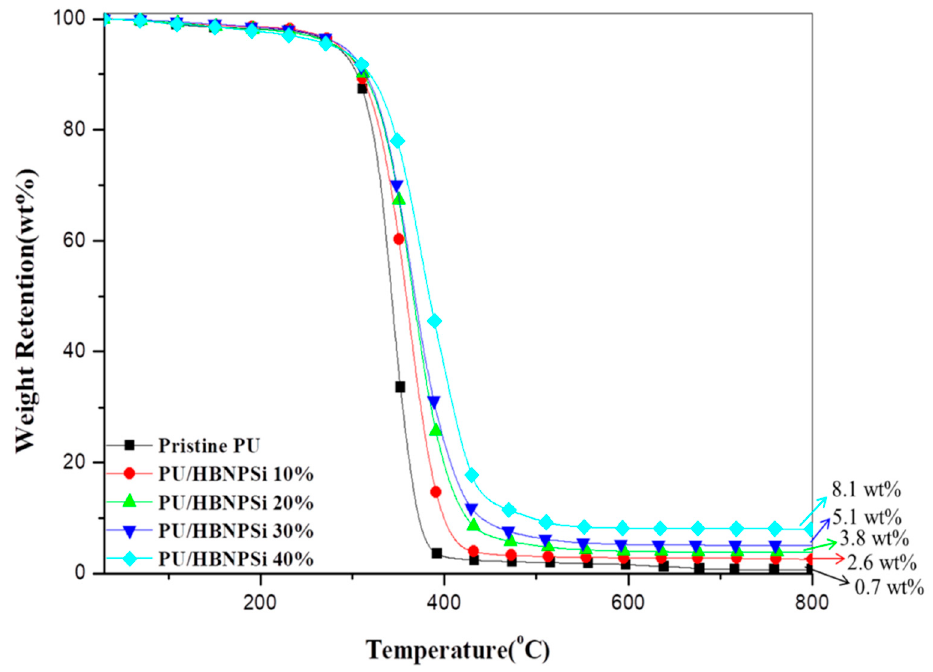
Figure 4. TGA curves of PU / HBNPSi hybrid in N 2 .